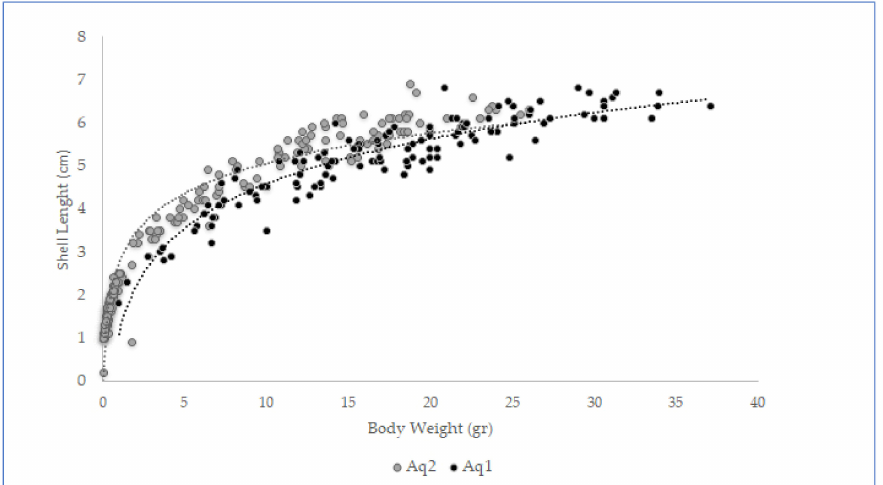
Figure A1. Shell length (cm) and body weight (g) measurements of mussel ( Mytilus galloprovincialis) in Aq1 (Epidavros) and Aq2 (Evoikos). Each dashed line represents the length-weight relationships (W = aln(L) + b) for mussels under IMTA conditions in Aq1 and